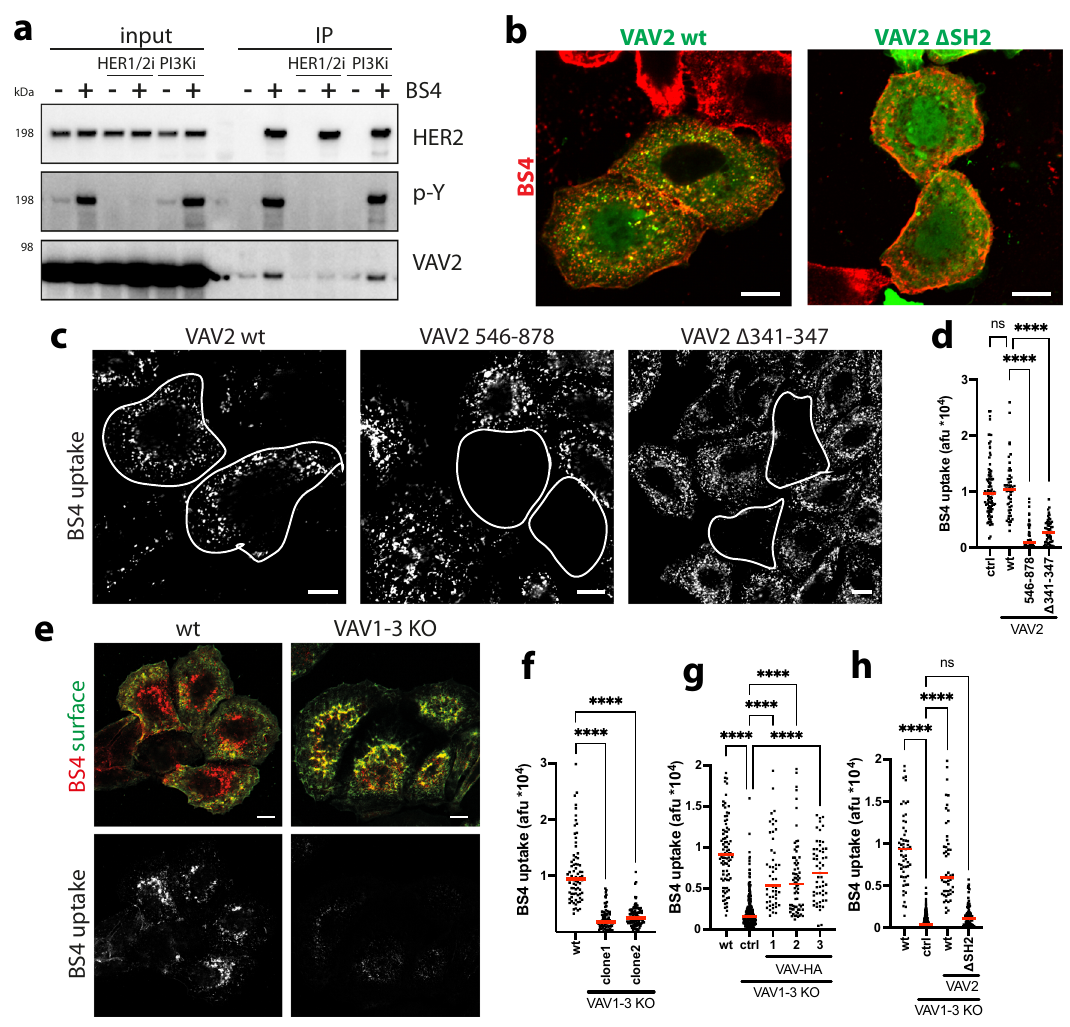
Fig. 8 | BS4-triggered ADE of HER2 critically requires VAV. BS4-induced inter- actionofHER2withVAV2isphosphotyrosinedependent( a ).SkBr3cells±lapatinib (HER1/2i) or LY294002 (PI3Ki) were incubated with BS4 for 2.5min. BS4-HER2 aggregateswereimmunoprecipitated and samplesanalysed by westernblot. VAV2 is recruited to BS4-HER2 aggregates via its SH2 domain ( b ). SkBr3 cells were transfected with VAV2 wt or lacking residues 665 – 772 ( Δ SH2) C-terminally GFP- tagged expression vector (green) for 16h followed by incubation with BS4- dylight650 (red) for 10min. After fi xation samples were analysed by confocal microscopy. BS4-induced ADE requires VAV2 GEF activity ( c , d ). SkBr3 cells were transfected with VAV2 wt, comprising amino acids 546 – 878, or lacking catalytic residues ( Δ 341 – 347) for 16h followed by incubation with BS4-dylight650 (red) for 30min. After fi xation, surface-bound BS4 antibody was counterstained and sam- ples were analysed by confocal microscopy. Subtraction of surface from total BS4signalshowsanendocytosedpool(BS4uptake),transfectedcellsareoutlined. Results are quanti fi ed in ( d ).VAV proteins are required for BS4 uptake ( e , f ).SkBr3 wt or VAV1-3 knockout (KO) cells were incubated with BS4-dylight650 (red) for 30min. After fi xation, the surface-bound BS4 antibodywascounterstained (green)